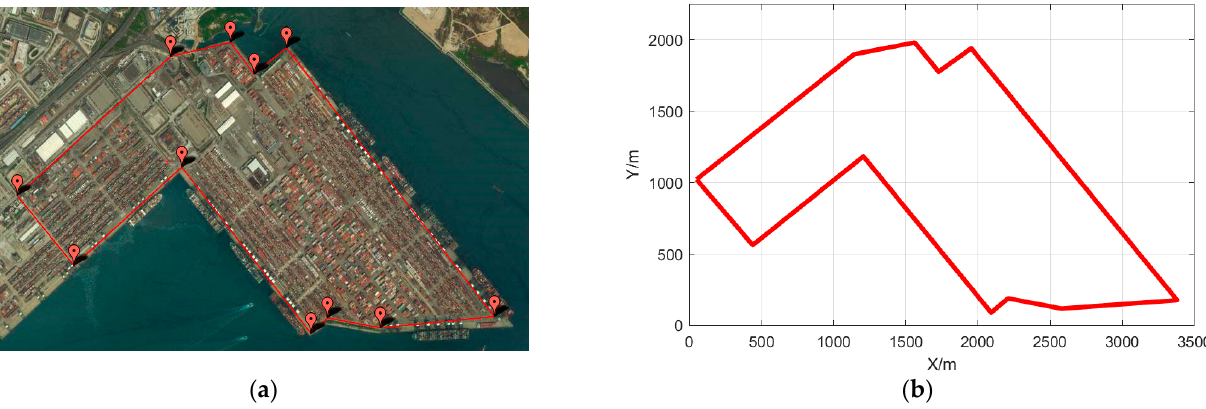
Figure 22. Remote sensing map and area map of the detection area 2. ( a ) Remote sensing map of detection area 2; ( b ) area map 2.